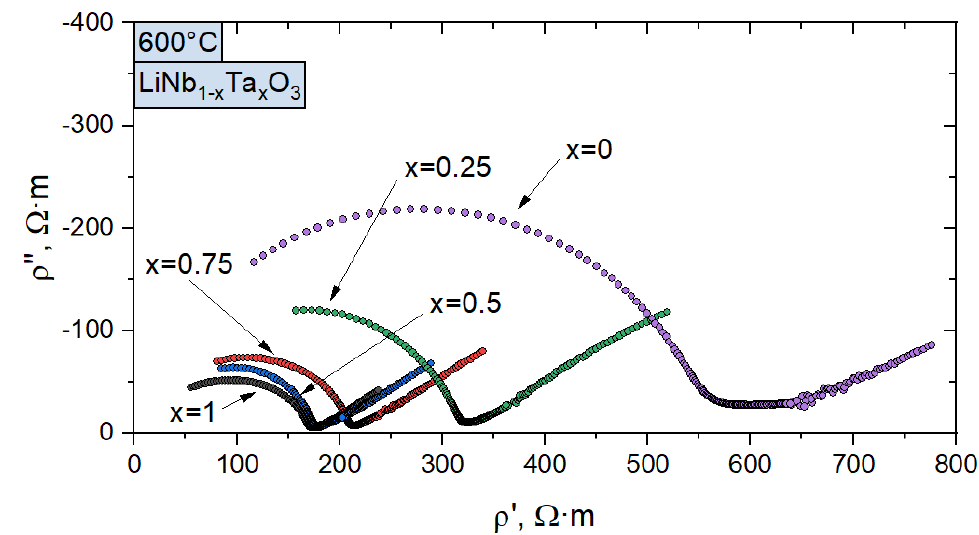
Figure 13. Complex impedance of the pressed LiNb 1 − x Ta x O 3 samples measured at 600 ◦ C. Impedance spectra of all samples at temperatures above 500 ◦ C reveal the existence of linear region of ρ ”( ρ ’) dependence, which follows the semicircle intercept at